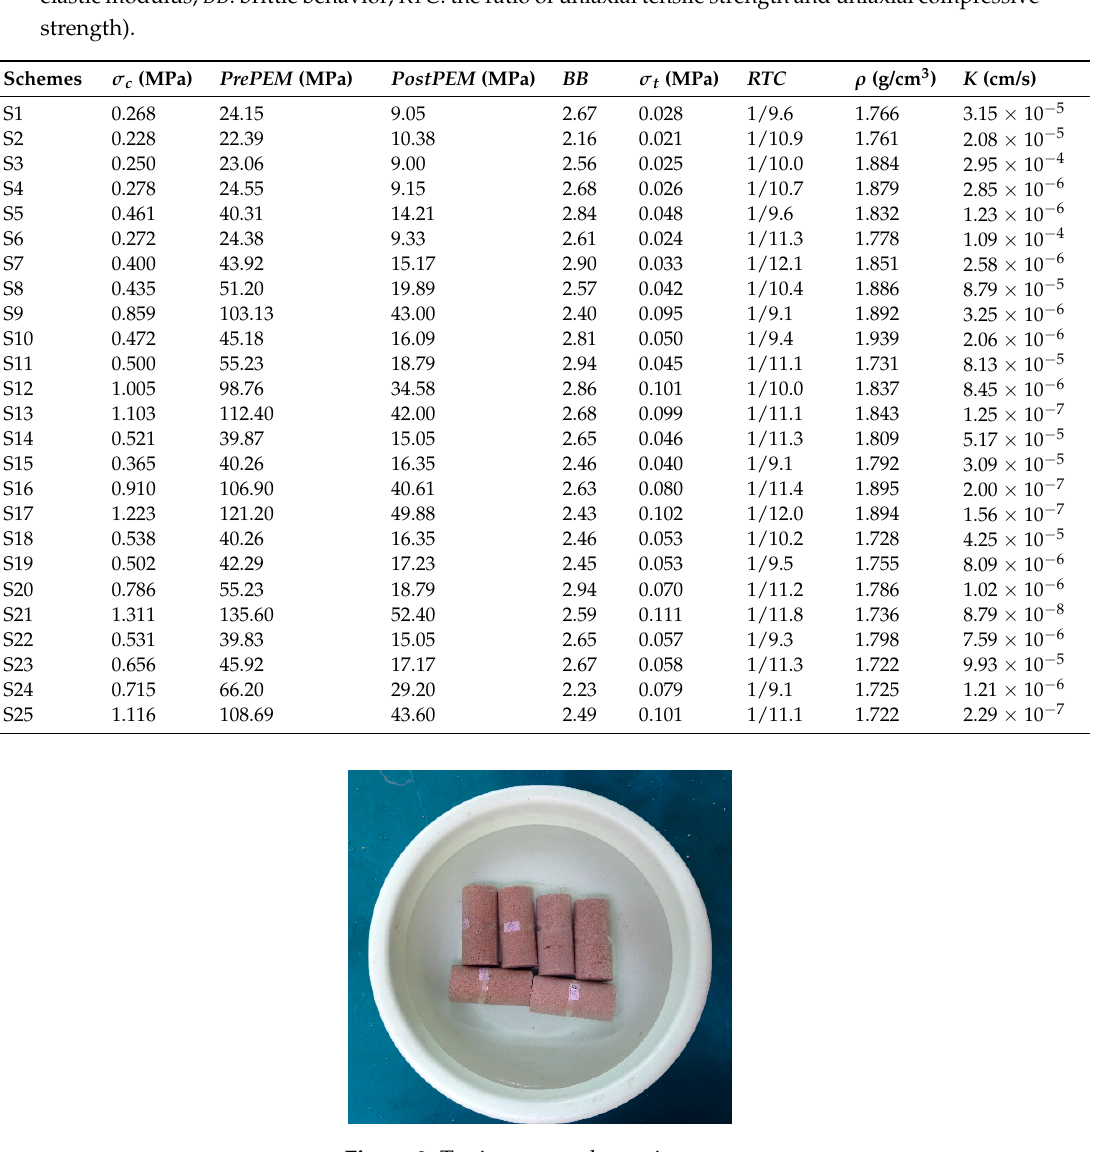
Figure 4. The trend of water absorption rate.